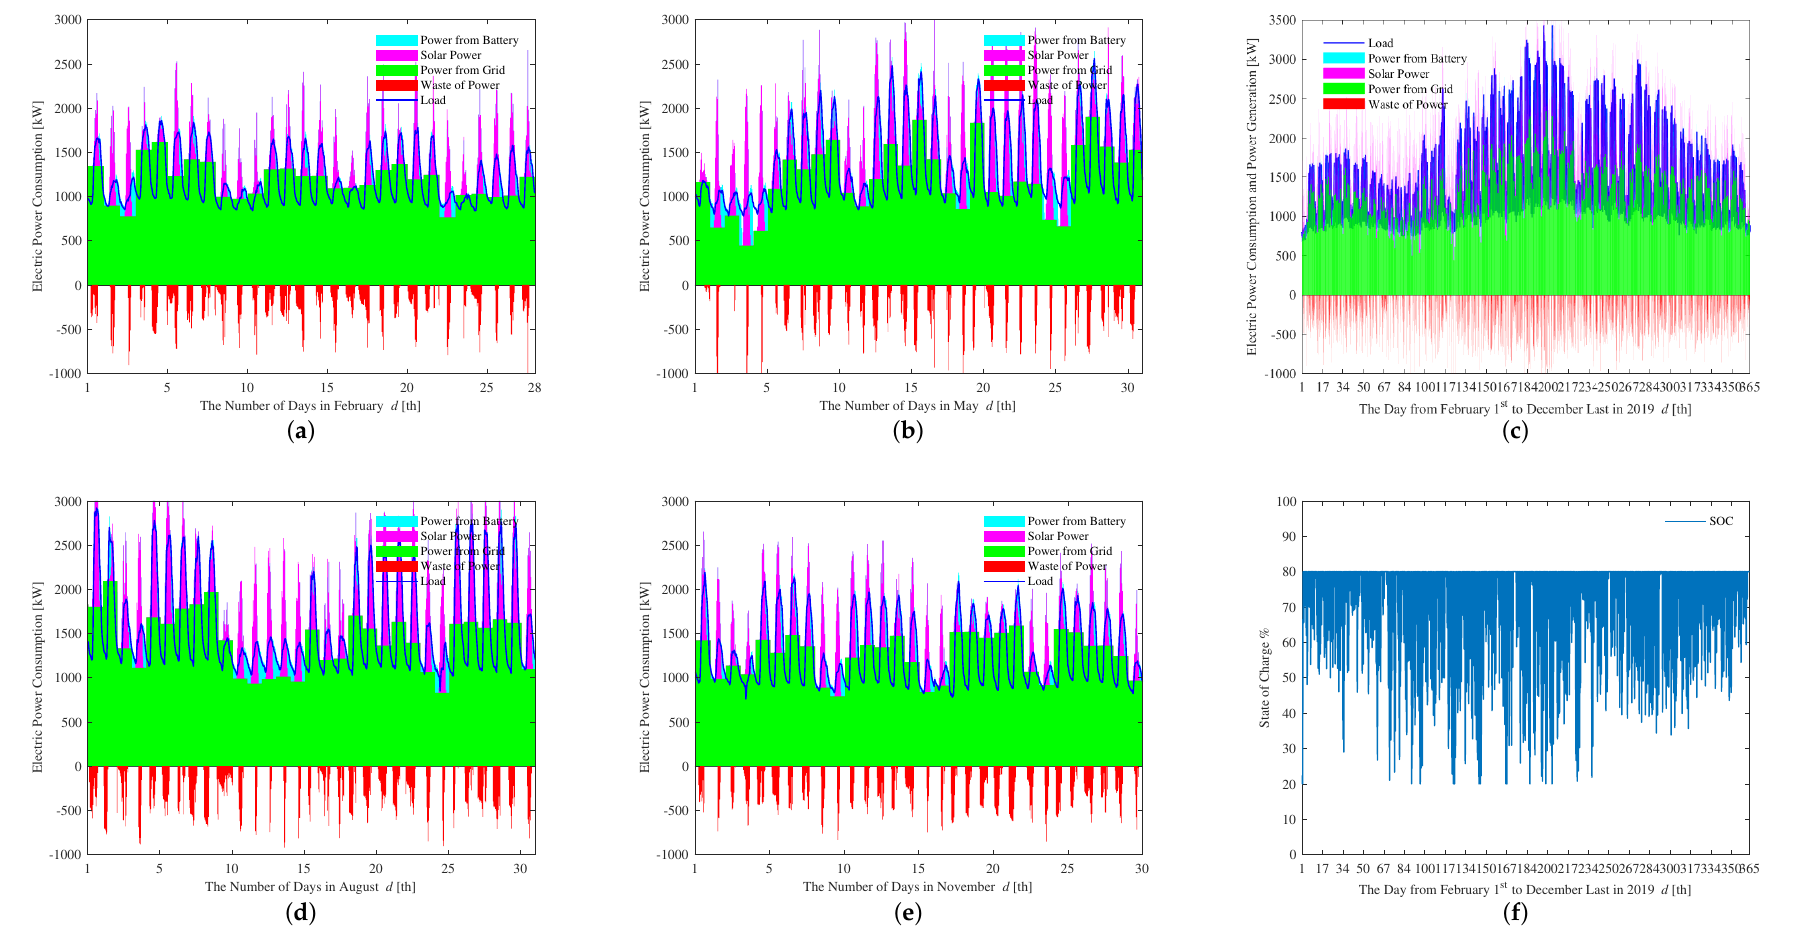
Figure 14. Simulation result of Case 3. ( a ) Simulation result of February; ( b ) Simulation result of May; ( c ) Simulation result of the whole year; ( d ) Simulation result of August; ( e ) Simulation result of November; ( f ) Simulation result of the whole year’s